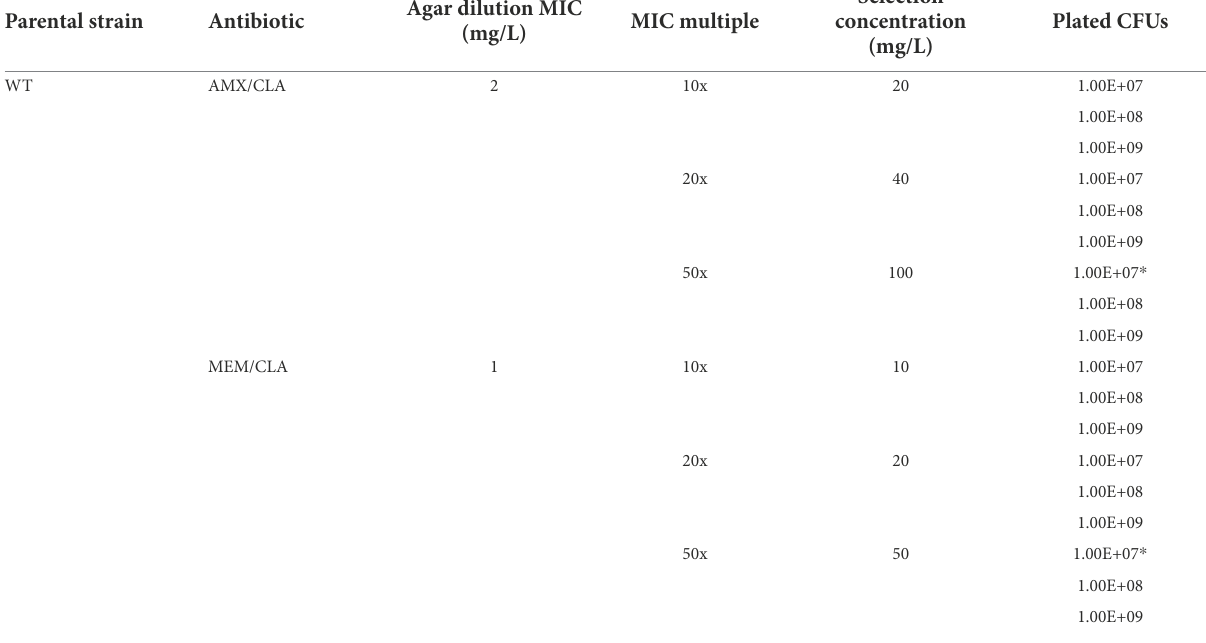
TABLE 2 Selection conditions used to obtain beta-lactam-resistant Mtb